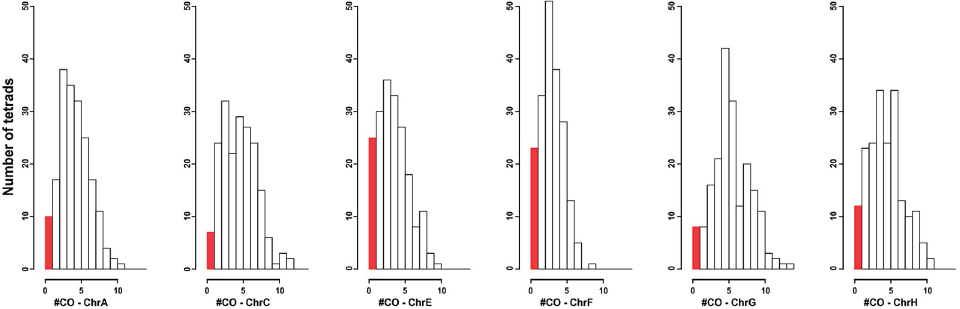
Fig 3. Non-exchange chromosome (E 0 ) frequencies in L . waltii . Histogram representing the frequency of crossovers per meiosis in each L . waltii chromosome. The red bars represent instances where no crossover was detected on the chromosome (E 0